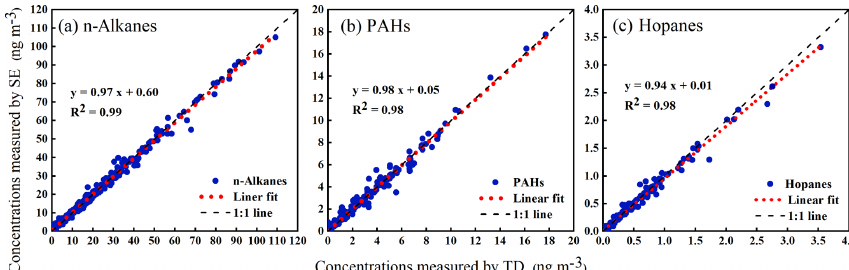
Figure 3. Comparisons of n-alkanes (a) , PAHs (b) and hopanes (c) determined by SE-GC-MS and TD-GC-MS methods for the ambient PM 2 . 5 samples collected simultaneously from Beijing, Shanghai, Guangzhou and Chengdu during the winter of